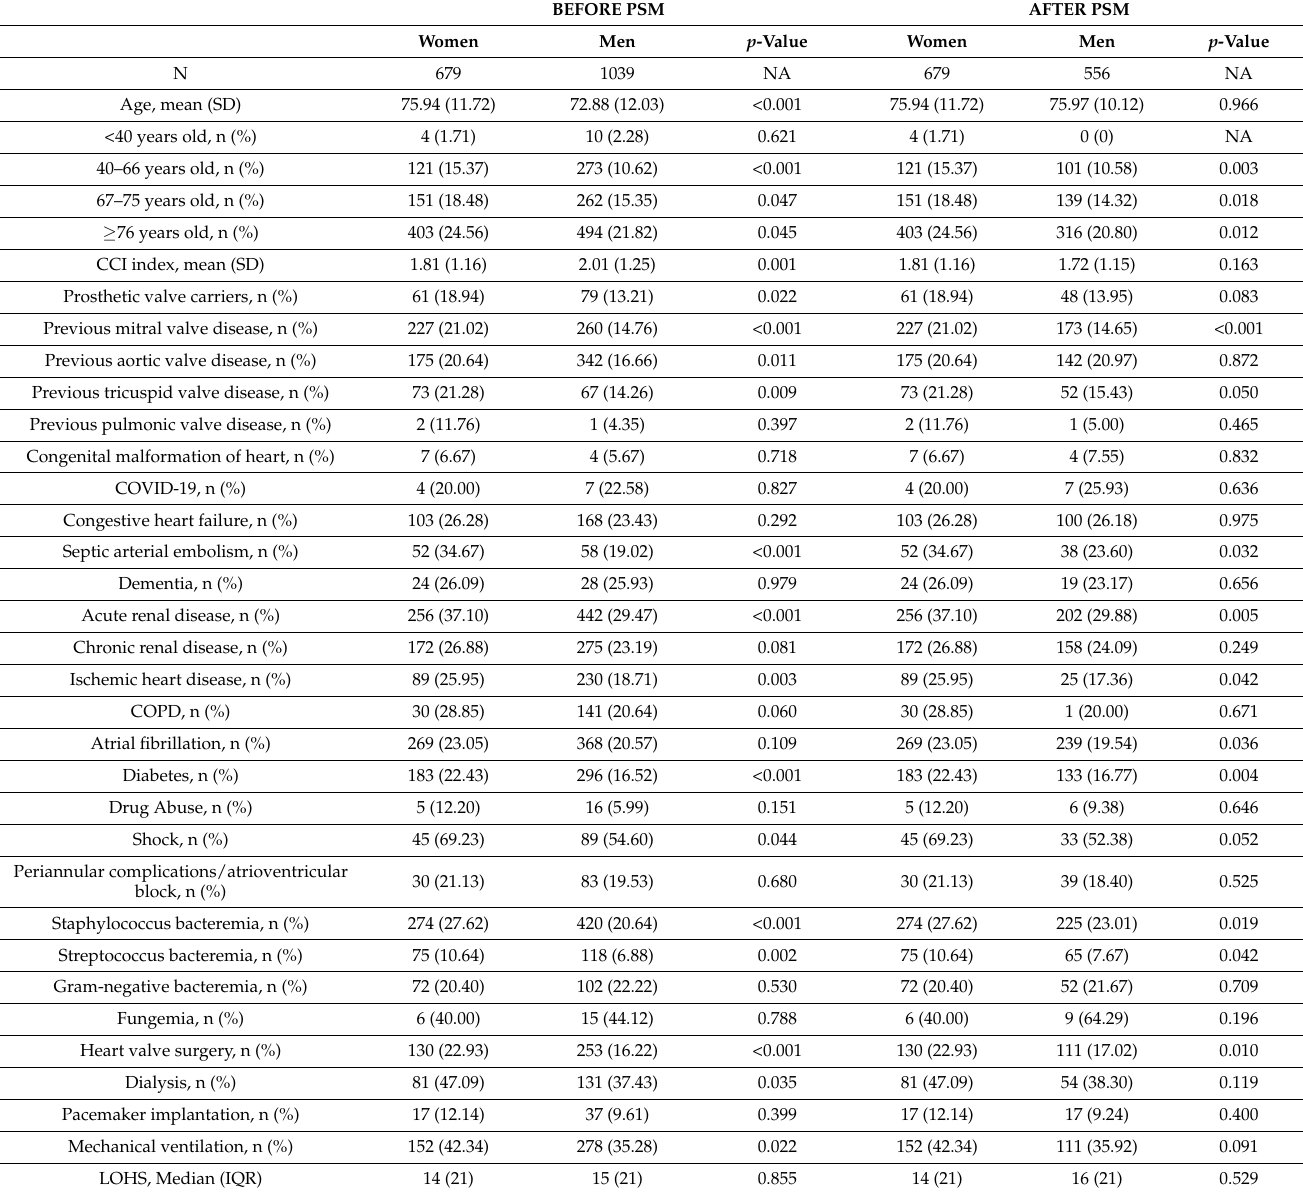
Table 4. In hospital mortality according to study variables of women and men with infective endocarditis in Spain (2016–2020), before and after propensity score matching (PSM). BEFORE PSM AFTER PSM Women Men p